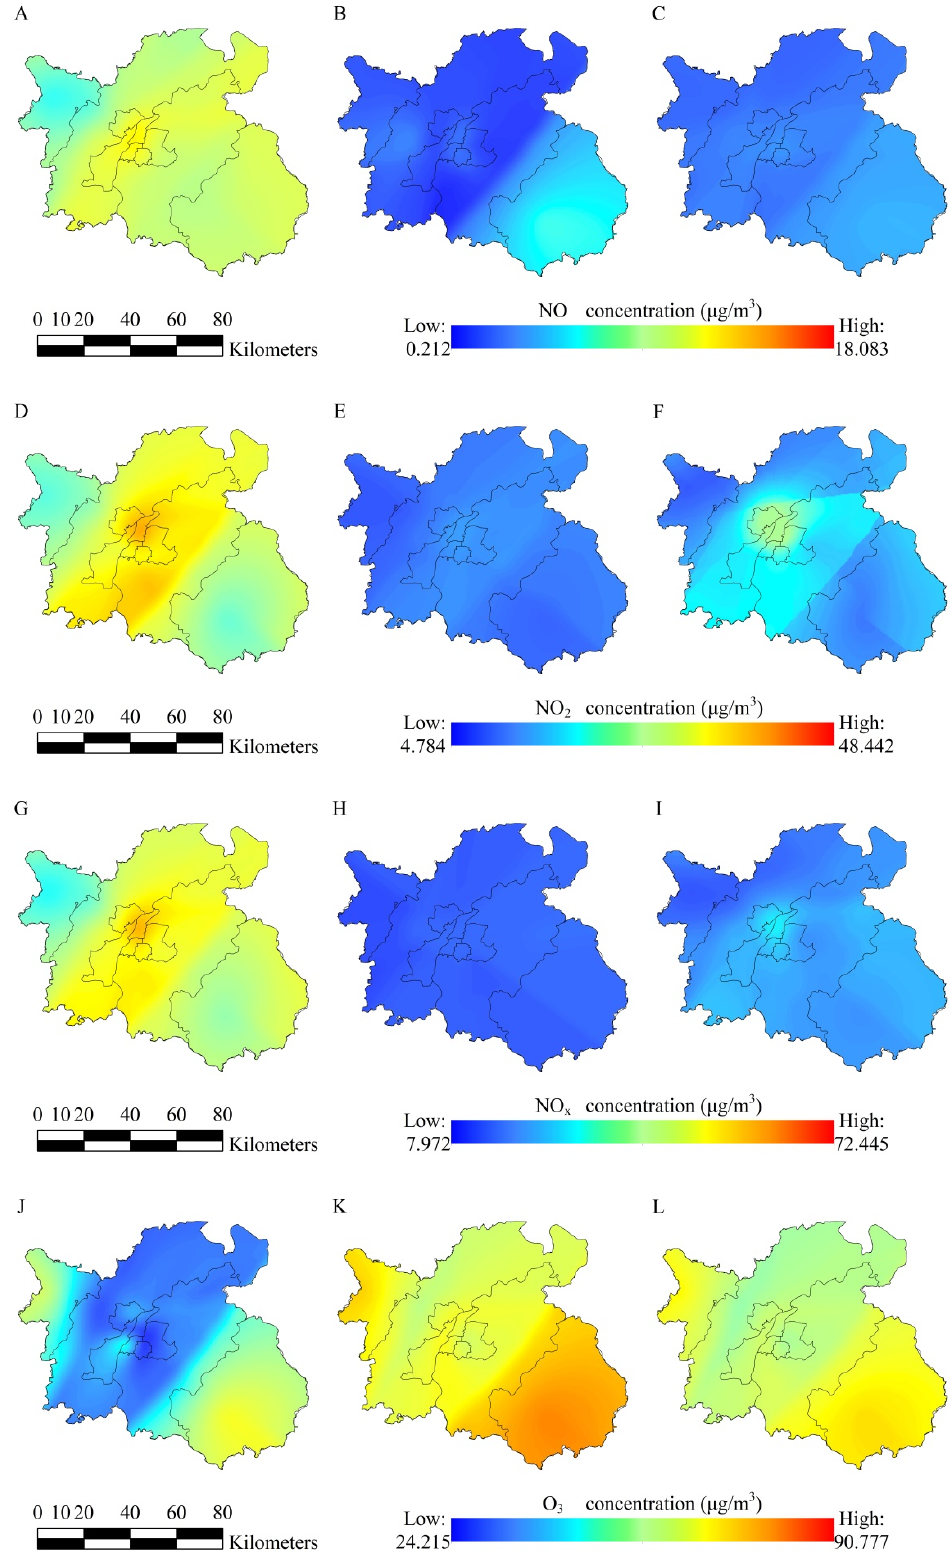
Figure 9. Spatial distribution of NO, NO 2 , NO X , and O 3 concentrations in ( A , D , G , J ) (before COVID-19), ( B , E , H , K ) (during COVID-19), and ( C , F , I , L ) (after COVID-19) periods over Nanchang.